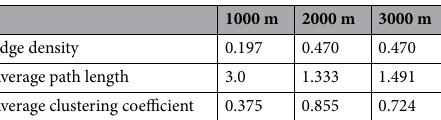
Table 1. Parameters characterizing the studied leaf trait networks at the three study sites (see Fig.